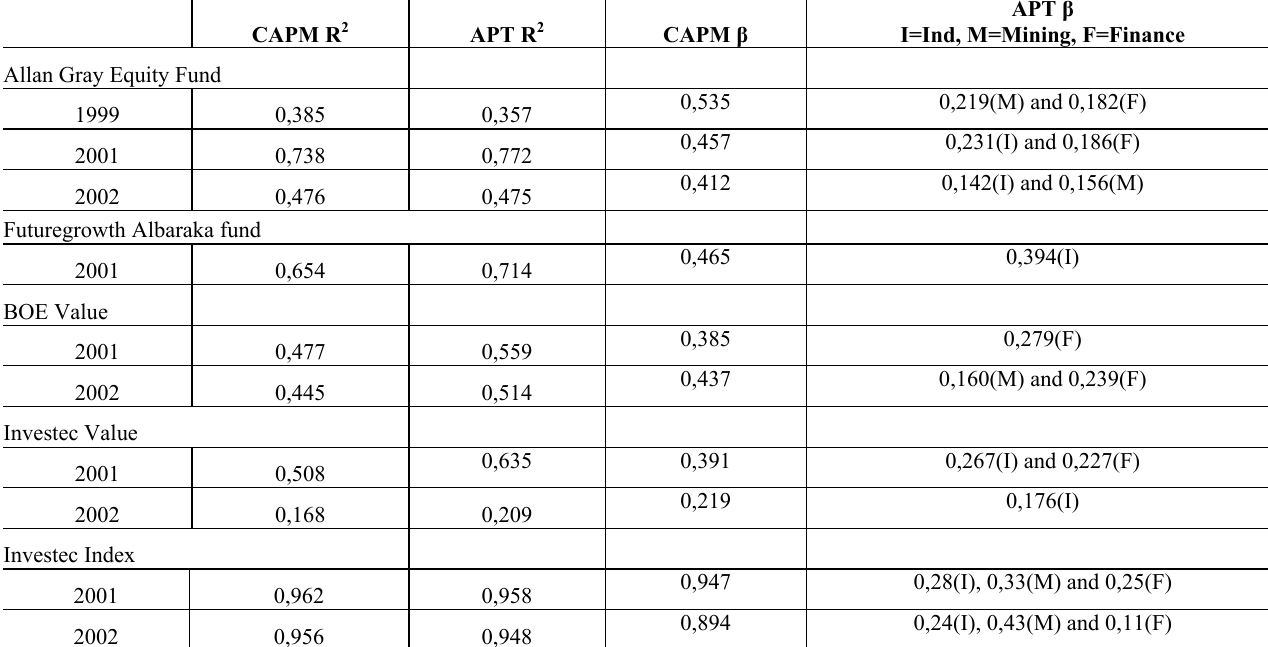
Table 4: R 2 and β